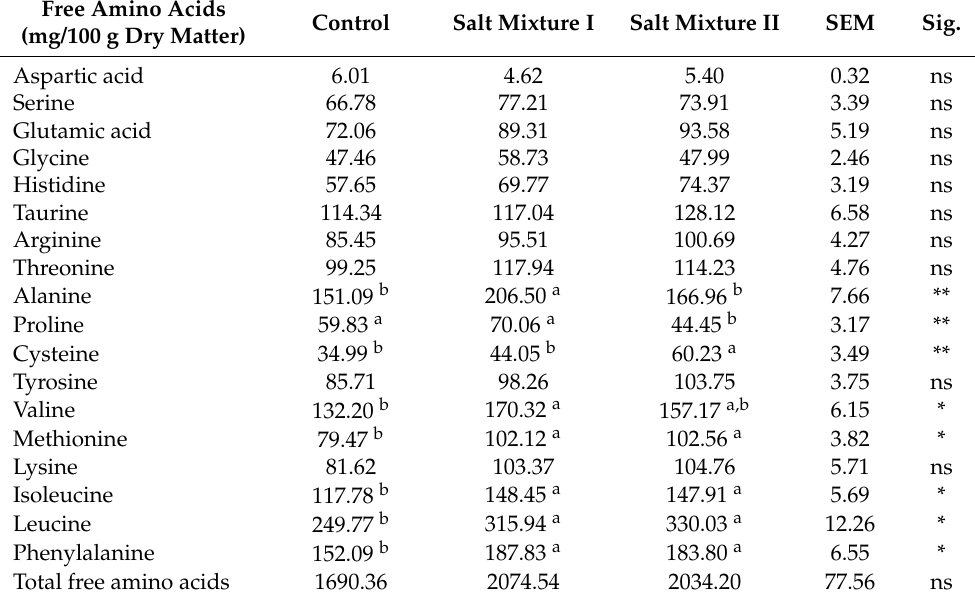
Table 4. Effect of NaCl replacement by other chloride salts on free amino acids of dry-cured deer